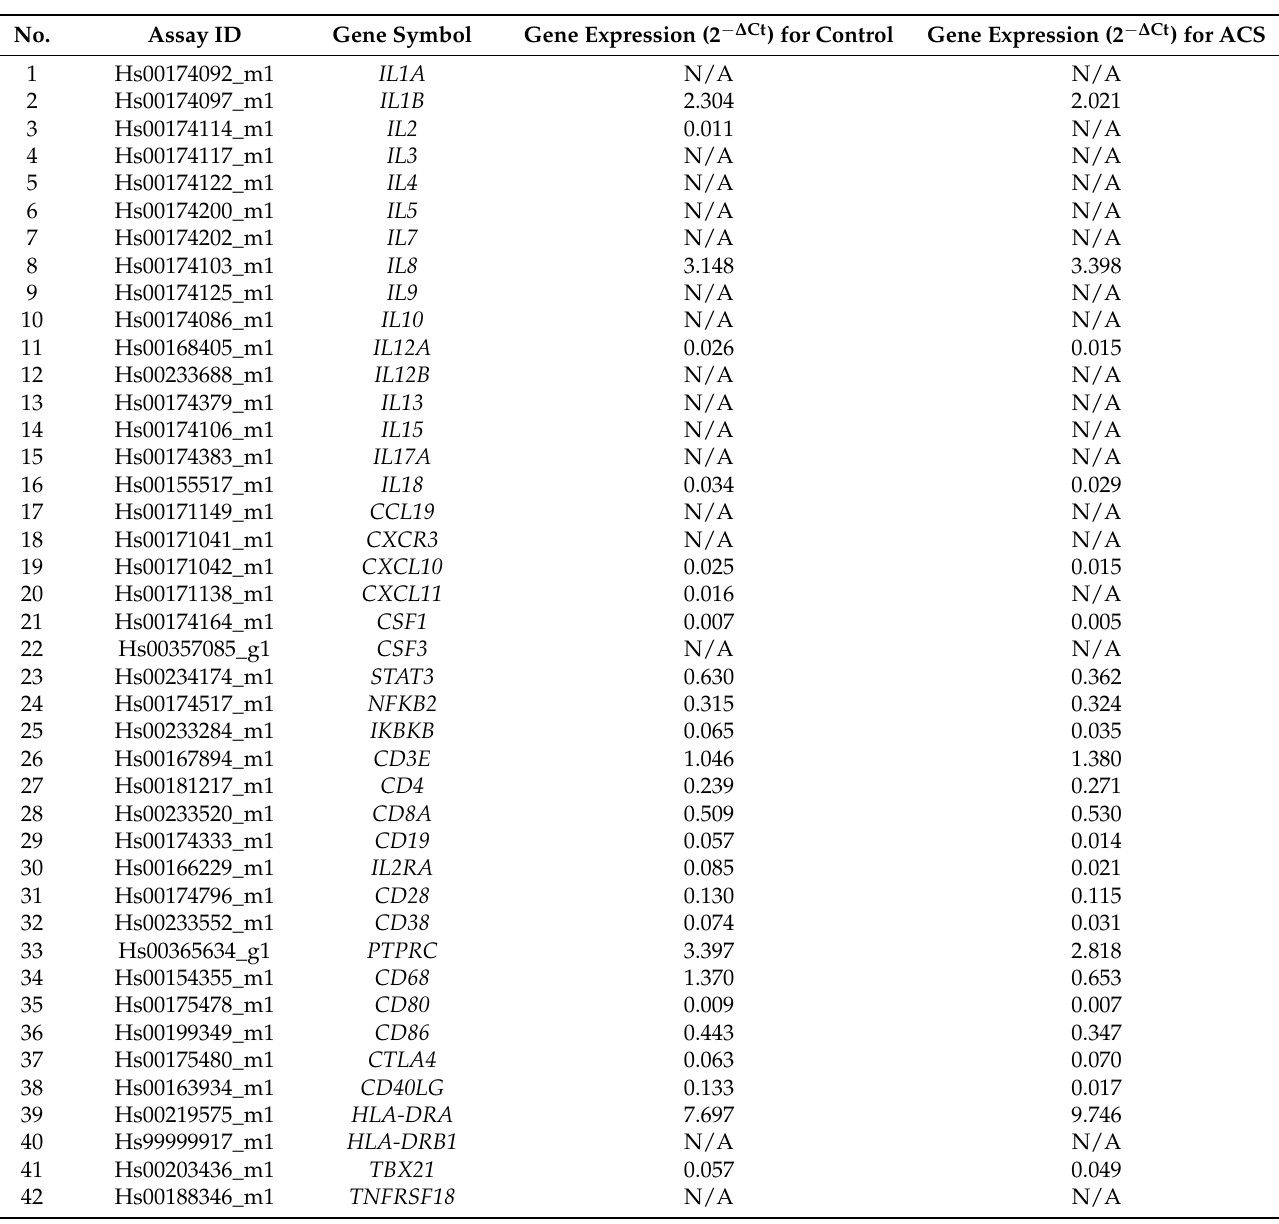
Table 3. Screening analysis of the expression of the remaining genes associated with the function of the immune system. All results are expressed as a mean of 2 − ∆ Ct (according to the reference gene encoding 18S rRNA); N/A–not available. The values of each mean gene’s expression in the study group are marked in red, while in the control group in